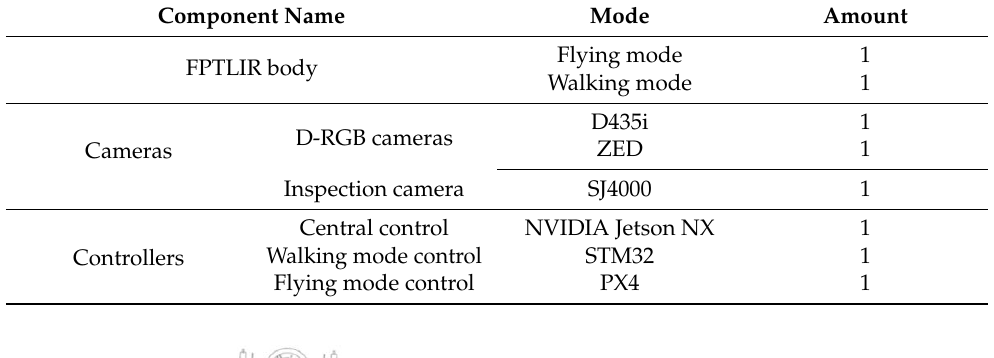
Table 2. The key components of FPTLIR.